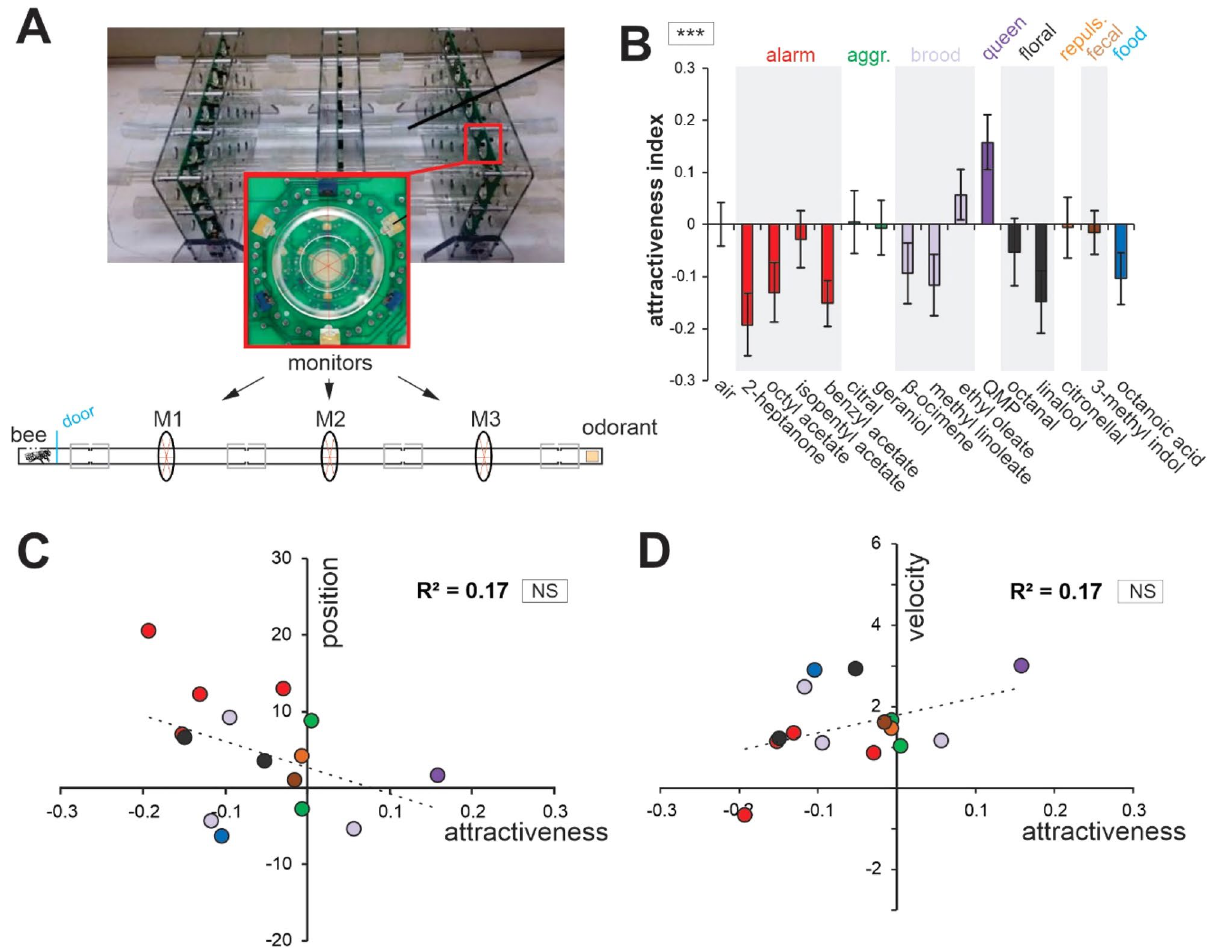
Figure 4. Attractiveness of the odorants and relationship with antennal movements. ( A ) Apparatus for measuring the orientation of 16 bees simultaneously, each confronted to a different odorant. It is made of 16 45 cm glass lines with each 3 equally interspaced infra-red portals (inset). At the start of the experiment, a box containing a worker is placed on one side of each line. A box containing a filter paper soaked with 5 µl odorant solution is placed on the other. The recordings start when opening the doors of the boxes containing the bees and lasts 10 min. From the numbers of passages through the monitors for each odorant and the air control, an attractiveness index is calculated (see text). ( B ) Histograms showing the relative attractiveness index of the odorants. Each bee was used to record the response to only one stimulus: air control N = 46, 2-heptanone N = 40, octyl acetate N = 44, isopentyl acetate N = 42, benzyl acetate N = 43, citral N = 40, geraniol N = 41, β-ocimene N = 43, methyl linoleate N = 40, ethyl oleate N = 42, QMP N = 37, octanal N = 39, linalool N = 40, citronellal N = 42, 3-methyl indole N = 43, octanoic acid N = 39. Asterisks in the square next to the graph indicate significant a significant heterogeneity in the attractiveness index of the different odorants (RM-ANOVA, ***: p < 0.001). ( C,D ) Regressions showing ( C ) the change in antennal angular position (Δθ) or ( D ) angular velocity (ΔVθ) as a function of each odorant’s attractiveness index. NS in the square next to the graph indicates the lack of statistical significance (p = 0.124 and p = 0.126